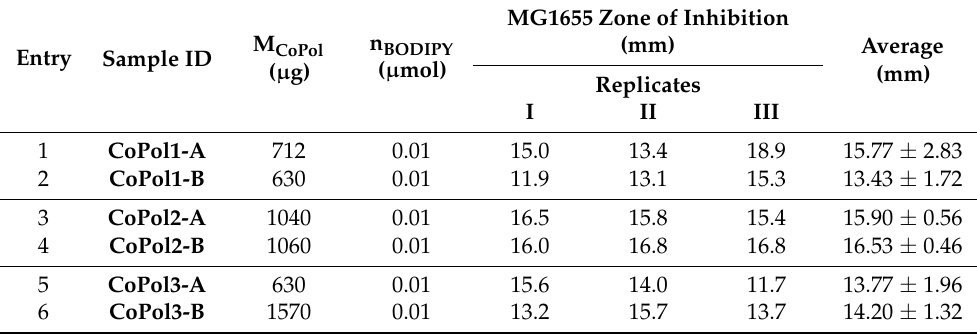
Table 3. Antimicrobial activity in E. coli K12-MG1655. Diameters (mm) of inhibitory haloes are reported as mean ± sd of at least three independent assays.